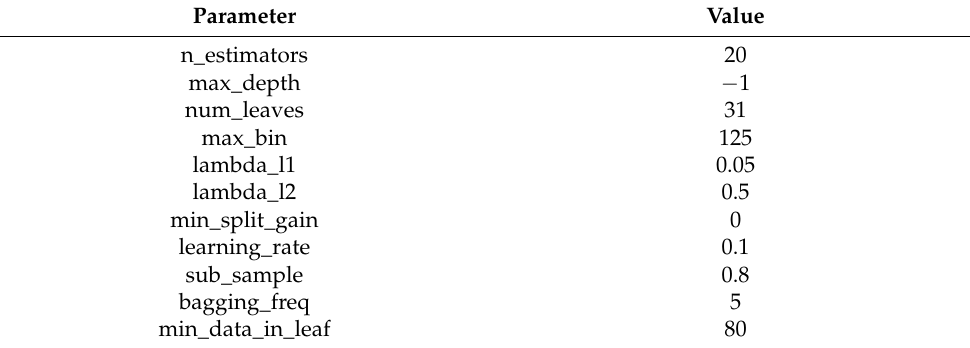
Table 6. LightGBM parameter tuning table.